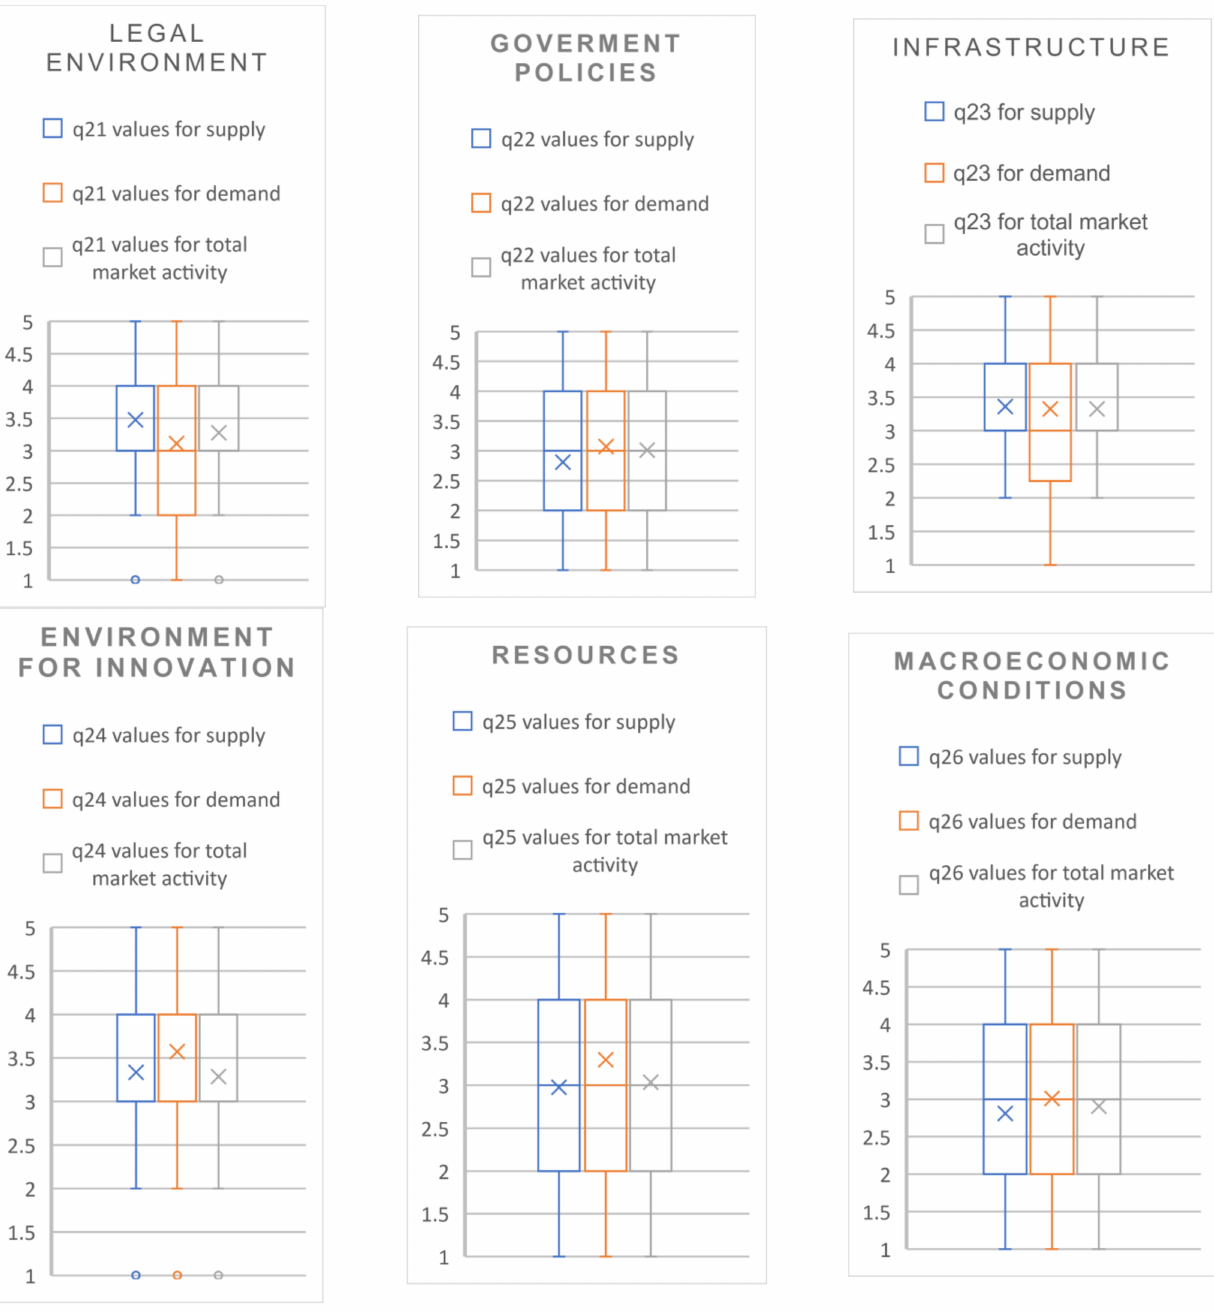
Figure 4. Values of the factors belonging to the metagroup